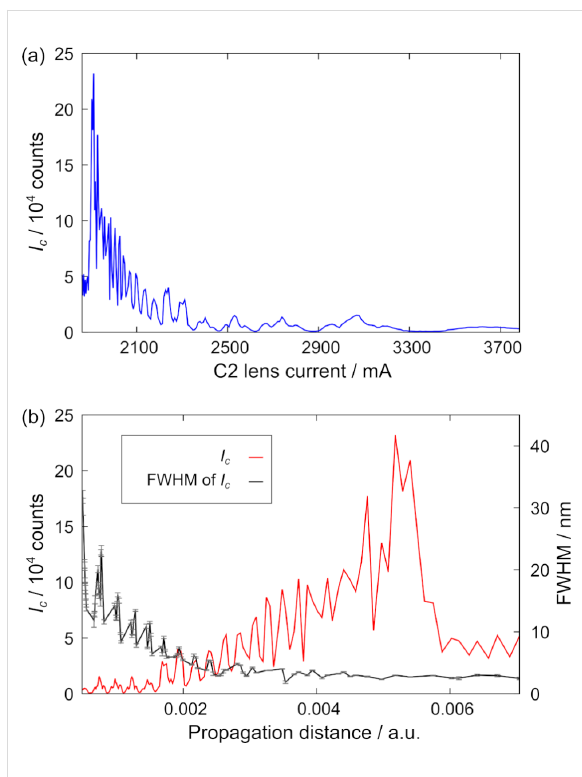
Figure 7: (a) Intensity in the center of a BB I C plotted as a function of the C2 lens current. The curve is reversed and compressed compared to the curves in Figure 6d. (b) Rescaling with Equation 6 linearizes the abscissa and qualitatively shows the propagation distance. Oscilla- tions and the linear increase in I C confirms the successful generation of a BB in the object plane. The FWHM of the central peak decreases upon propagation as a change of C2 excitation also changes the demagnification. Error bars correspond to the fitting error of the Gaussian